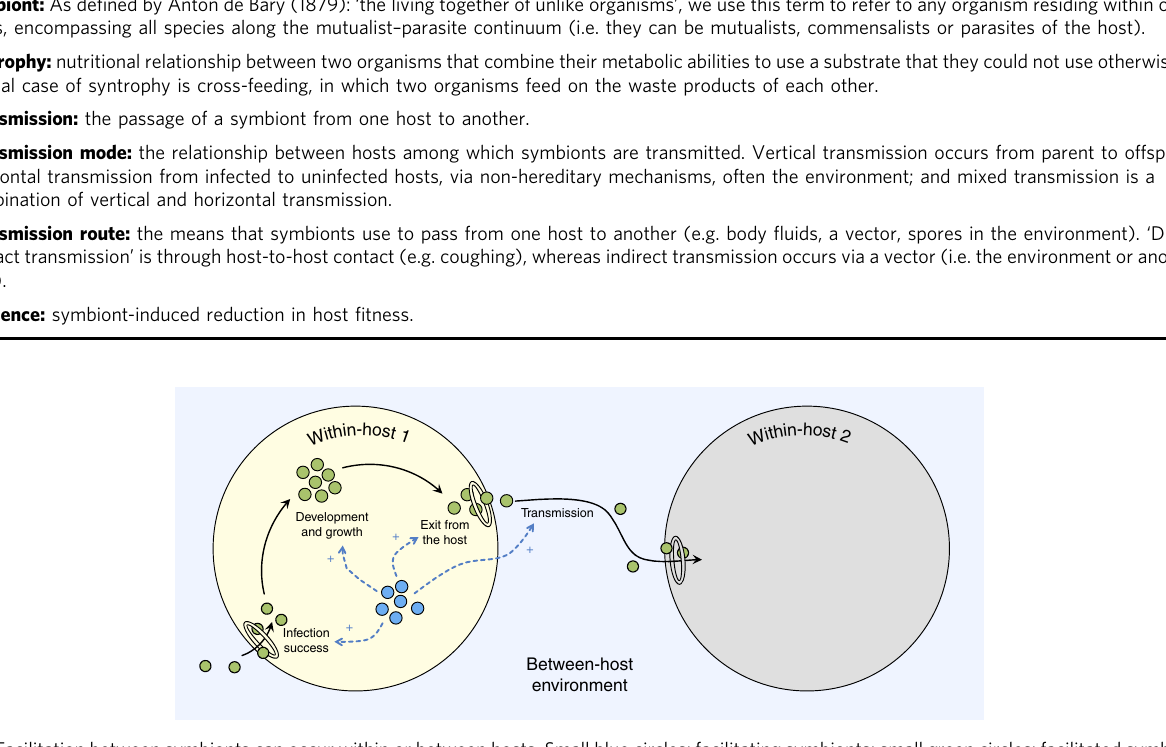
Fig. 2 Facilitation between symbionts can occur within or between hosts. Small blue circles: facilitating symbionts; small green circles: facilitated symbionts; big yellow circle: co-infected host; big grey circle: uninfected host; rings: entry/exit point of the host; blue dashed arrows: facilitation; black solid arrows: transition between life cycle stages of the facilitated symbiont. Traits facilitated are categorised as ‘ development ’ (i.e. symbiont growth or differentiation) in the within-host environment, ‘ infection success ’ (i.e. host entry or establishment), ‘ exit from the host ’ at the interface between the within- and between- host environment, and ‘ transmission ’ in the between-host environment. Note that the diagram does not consider the symmetry of the interaction (i.e.